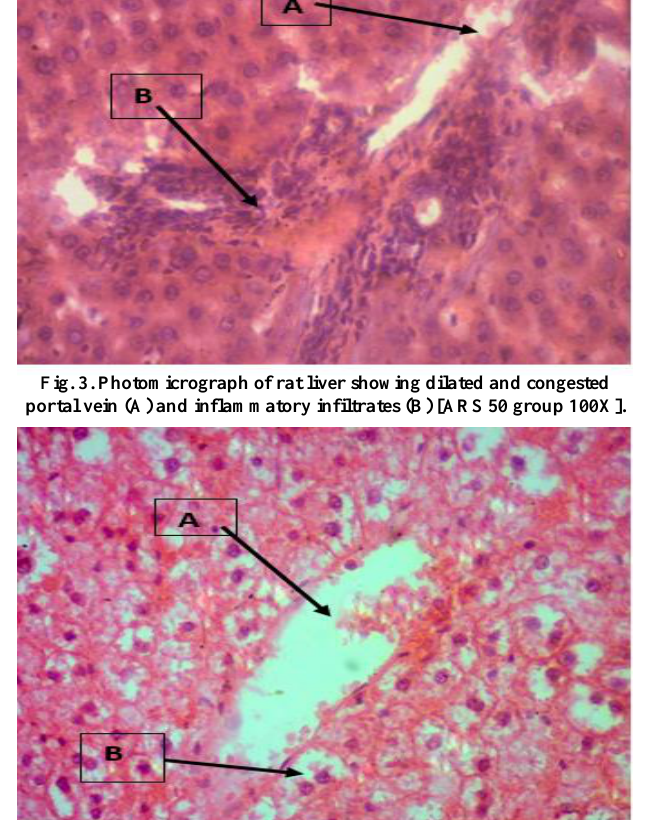
Fig. 6. The photomicrograph of the rat kidney shows a decrease in glomerular size and peri-glomerular space (A) and interstitial hemorrhage [ARS 50 Group 10 X].